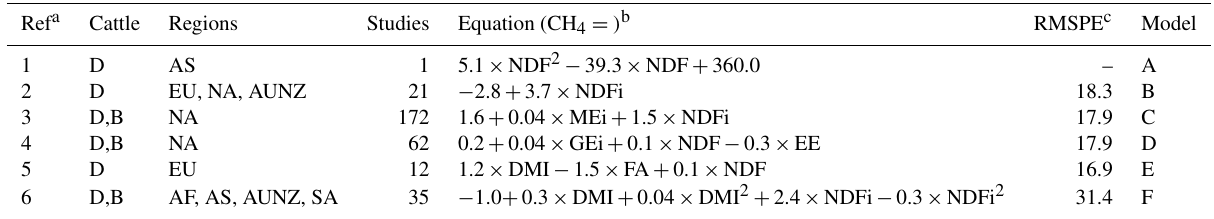
Table 1. A summary of the published equations used to model changes driven by grass nutritive quality in methane production, giving the details for cattle type (D is dairy and B is beef), regions covered (AF is Africa, AS is Asia, AUNZ is Austalia and New Zealand, EU is Europe, NA is North America and SA is South America) and the number of studies included in each analysis. The values for root mean square prediction error (RMSPE) are also